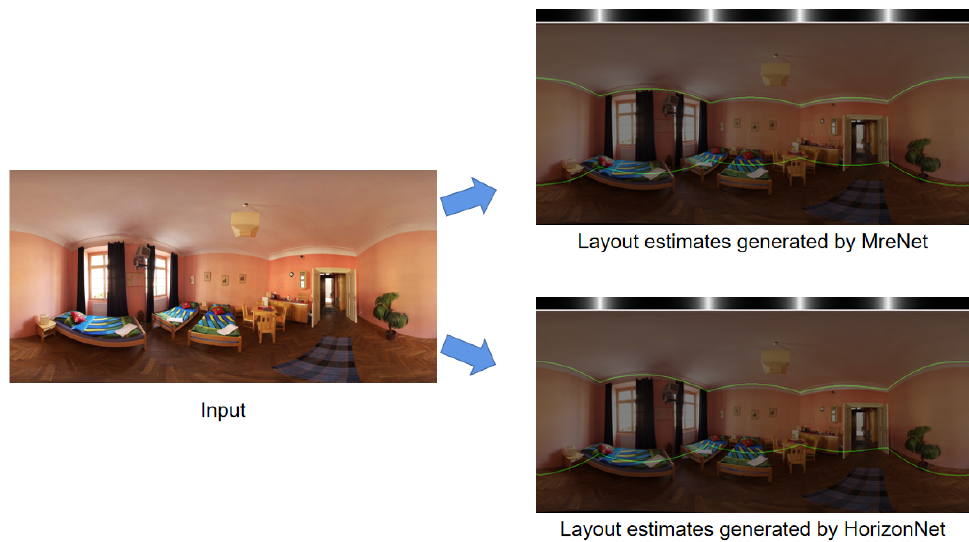
Figure 6. Layout estimates generated by MreNet and